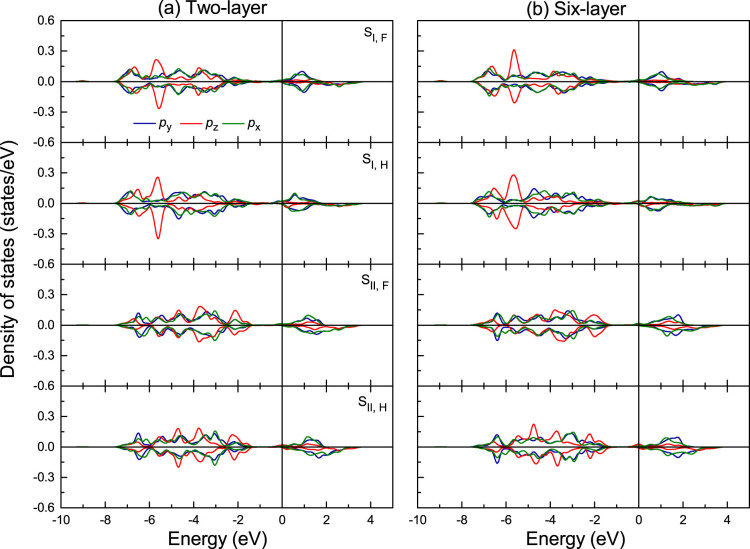
DOS of the S atoms at the F and H sites for the two- and six-layer Gd/MoS2 interfaces.